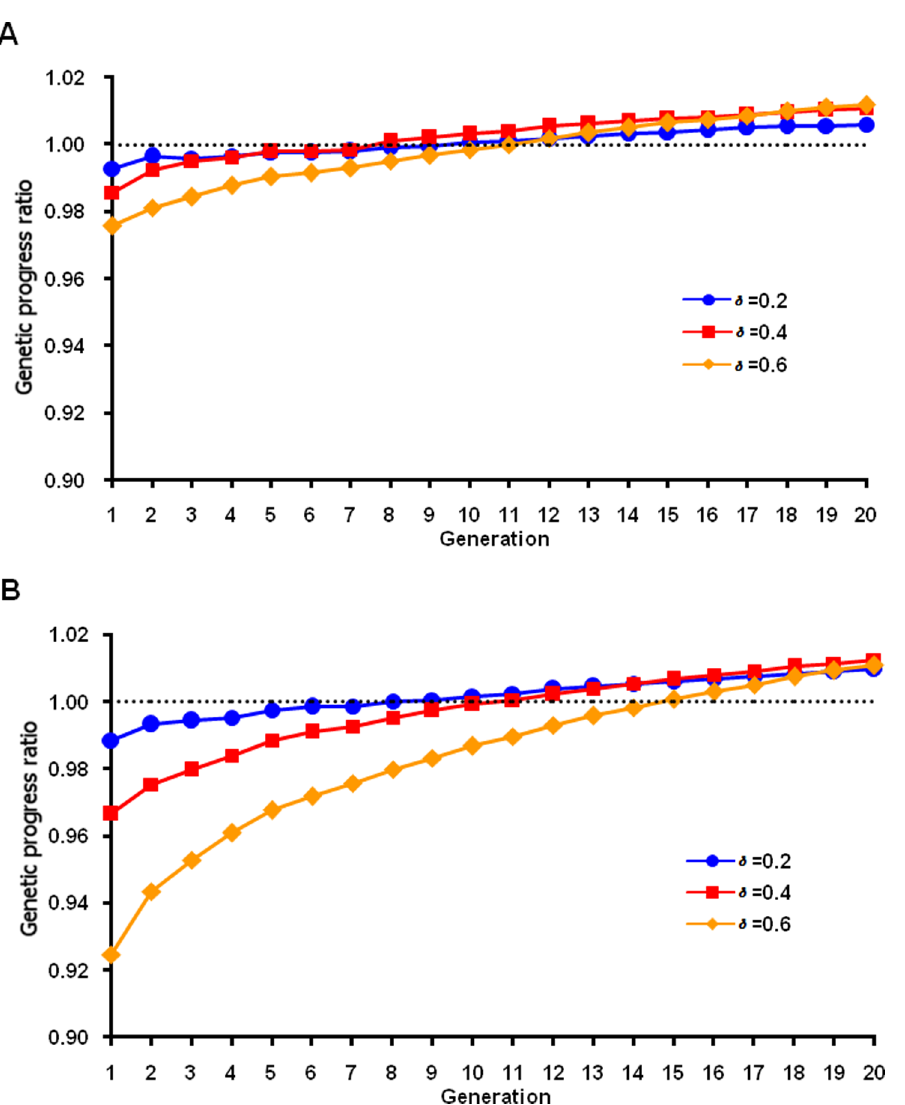
Figure 4. Ratio of adjusted to unadjusted genetic progress by generation for a heavy-tailed QTL distribution. The ratio was calculated as the genetic progress for a simulated population based on adjusted genomic breeding value using various d in the linear (A) and nonlinear (B) adjustment formula divided by genetic progress based on genomic breeding value from unweighted selection.